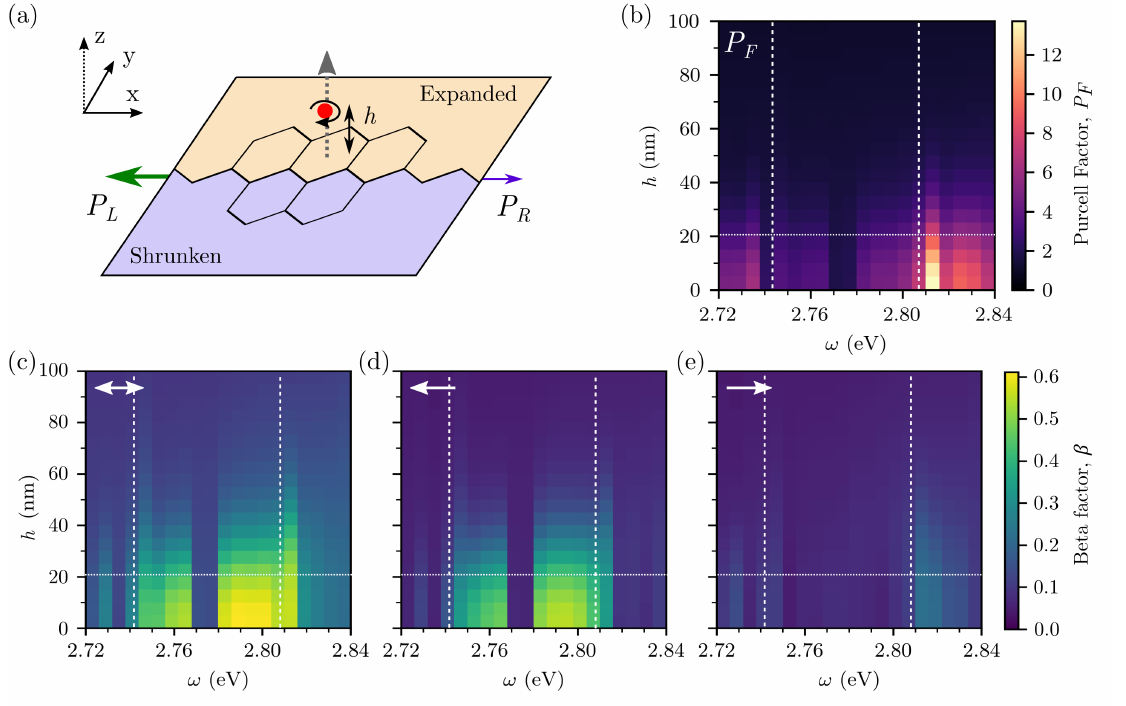
Figure 2. Single sources at varying heights h and frequencies ω : ( a ) Schematic showing the layout of the interface. The system is 40 unit cells along x and 12 unit cells along y , with 6 contracted and 6 expanded unit cells. A left circularly-polarized source (red) is placed at the centre of an expanded unit cell and moved upwards. The power through the left P L and right P R channels is used to characterise the directionality. ( b ) Purcell factor P F of the source. The height of the NPs is shown as a horizontal dotted line and the edges of the band gap are shown as vertical lines. Beta factors: ( c ) Power coupling into the edge β edge (double arrow). Power coupling into the ( d ) left β L , and ( e ) right β R channels (left and right